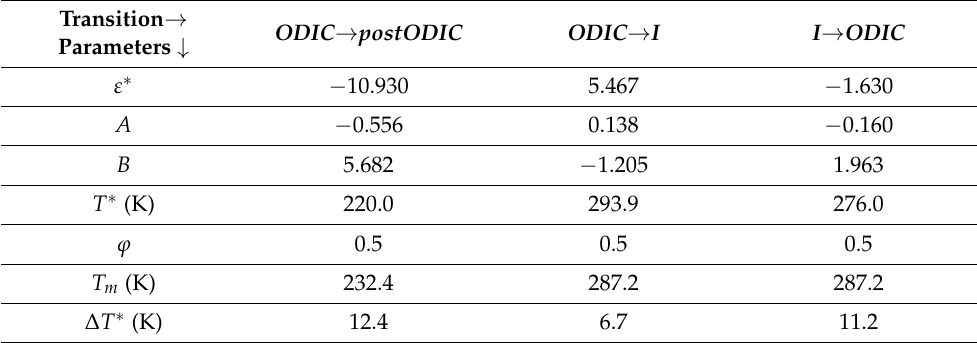
Table 1. Values of parameters describing NDE vs. T experimental data in the liquid and ODIC phases of cyclooctanol (Figure 6) when portraying by Equation